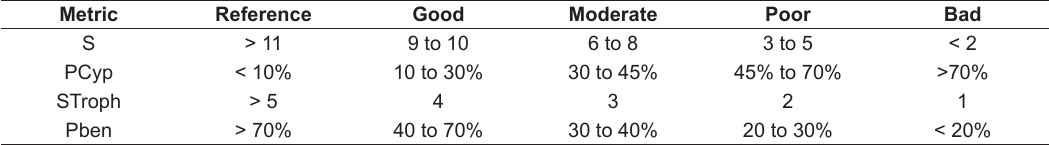
Table 7. Multimetric fish index (MFI) metrics (see Table 3) and class boundaries for Sorocaba City streams. Metric